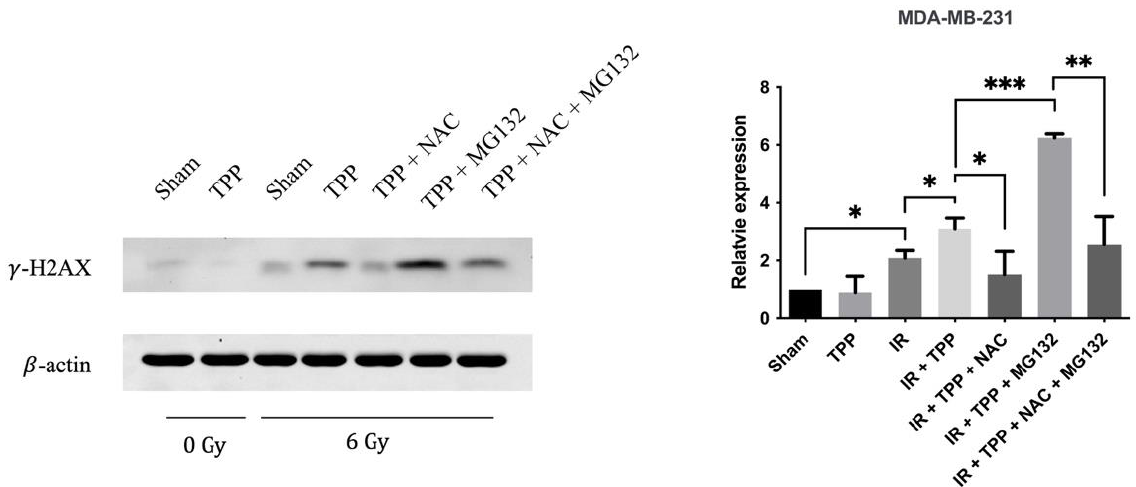
Figure 9. DNA DSBs induced by TPP-PEG4-FeAuNPs are dependent on ROS production in MDA- MB-231 cells. MDA-MB-231 cells were treated as described in Figure 7. Cells were harvested 1 h after irradiation for Western blotting. γ -H2AX was used to determine DNA DSBs. β -actin was used as a loading control. The uncropped Western Blot images can be found in Figure S4. Abbreviations: IR, irradiation; TPP, TPP-PEG4-FeAuNPs; NAC, N-Acetyl-L-cysteine; MG132, Z-Leu-Leu-Leu-al. Significance: * p ≤ 0.05, ** p ≤ 0.01, *** p ≤ 0.001; resul ts represent the mean values ± SD of 3 independent